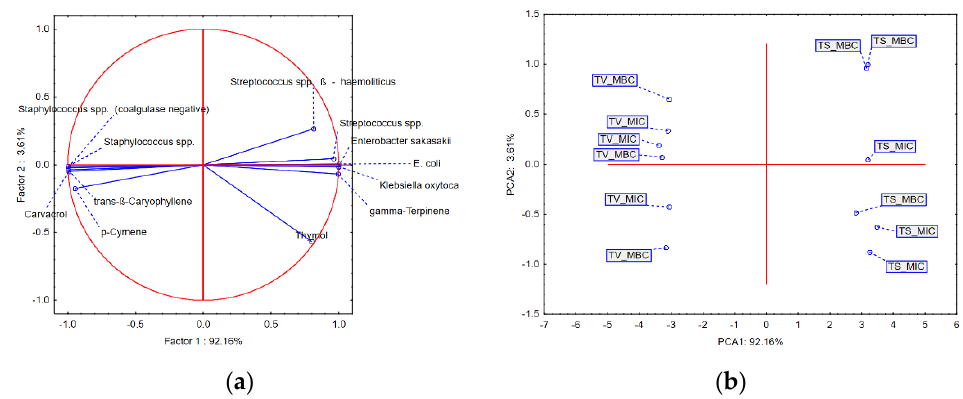
Figure 3. Results of principal components analysis (PCA): ( a ) loadings of the first two principal components; ( b ) position of the examined samples in the space defined by the first two principal components. TS, T. serpyllum ; TV, T. vulgaris ; MIC, minimum inhibitory concentration; MBC, minimal bactericidal concentration.